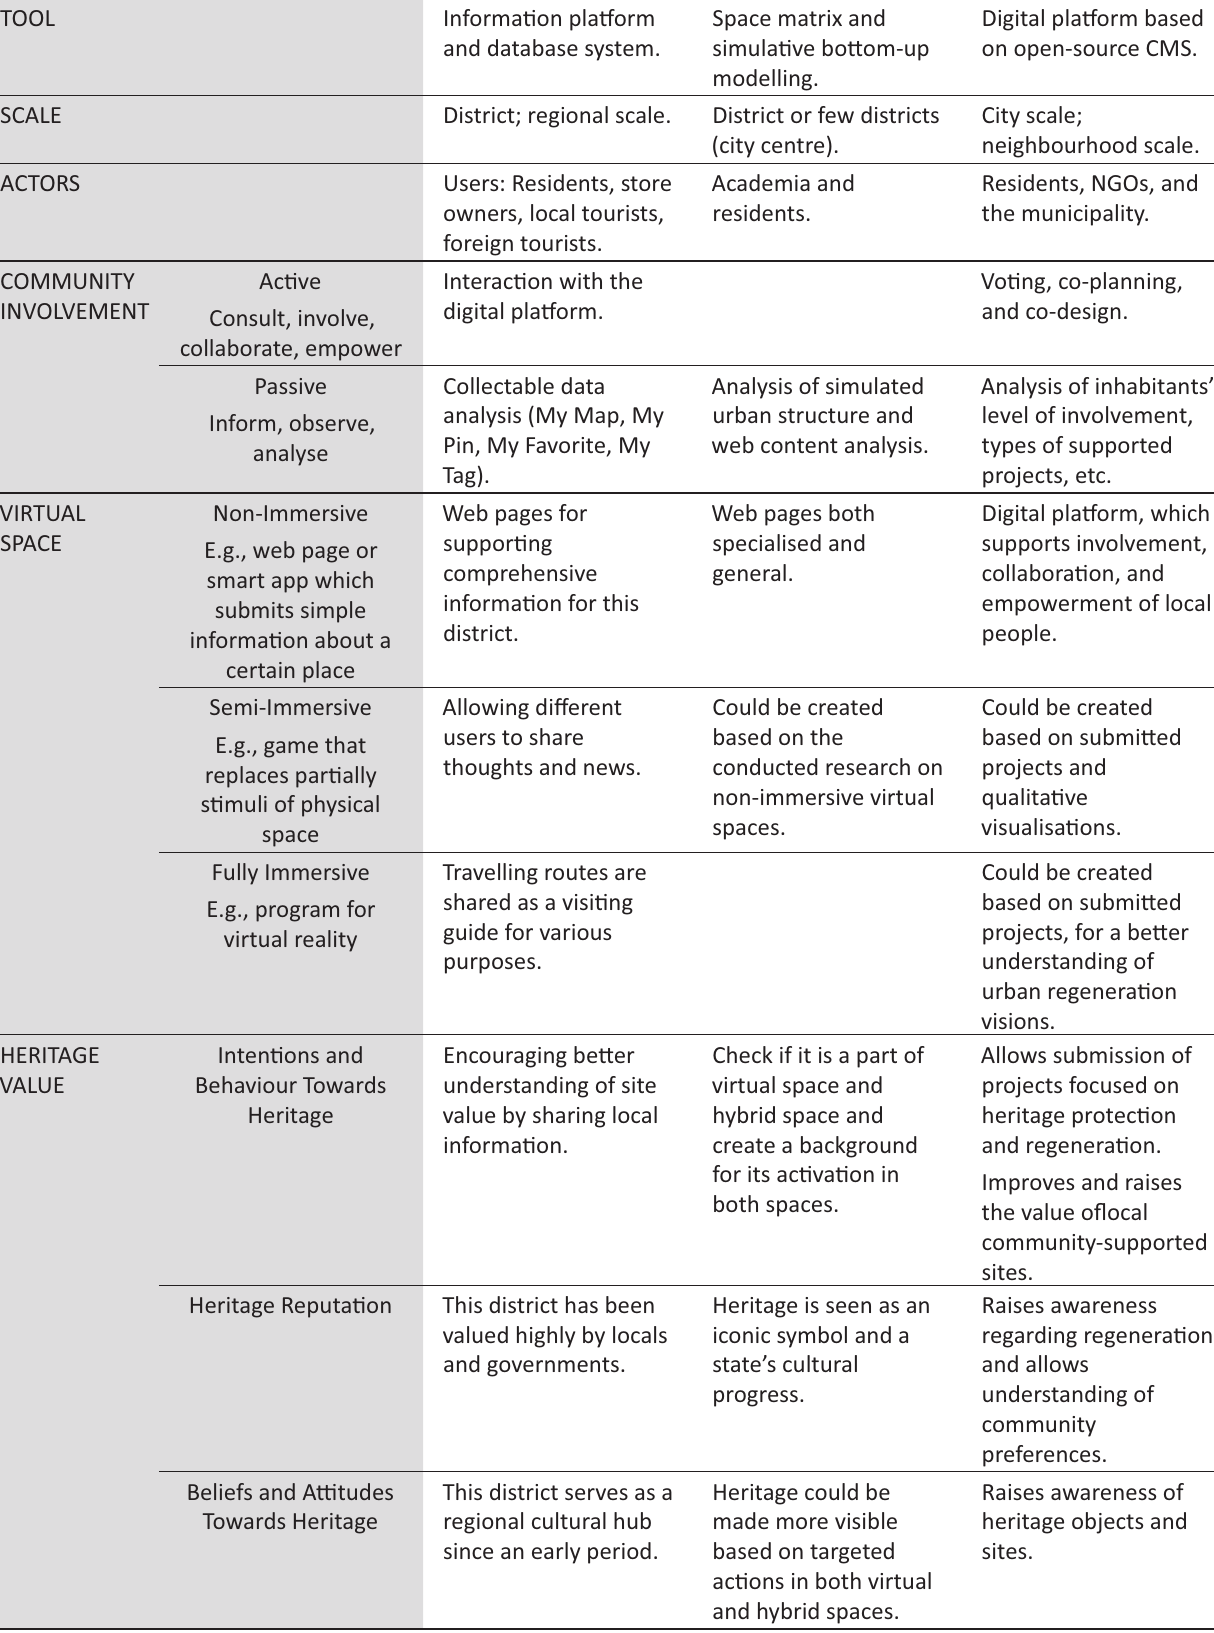
Table 1. Key characteristics and configurations of the digital placemaking tools.